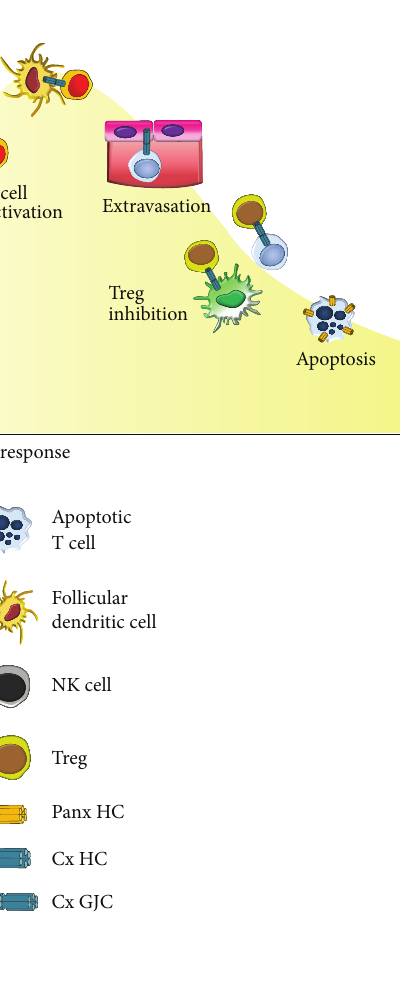
Figure 7: Scheme of different stages of classical immune response. The reported role for connexin- and pannexin-based channels is depicted in different immune cells functions as migration, antigen presentation, clonal expansion, and